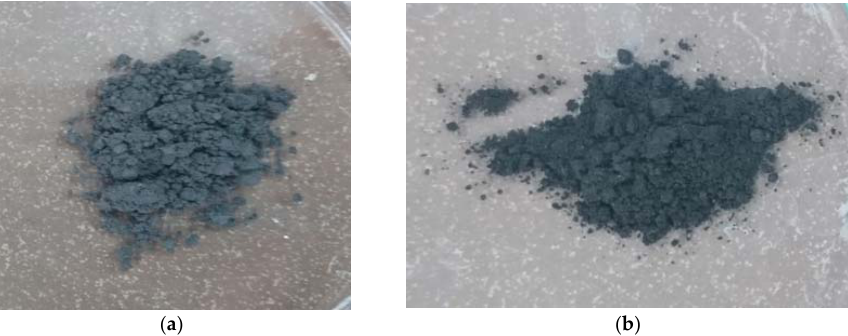
Figure 1. Graphene nanopowder ( a ) and carbon nanotubes ( b ) used as admixtures in PLA